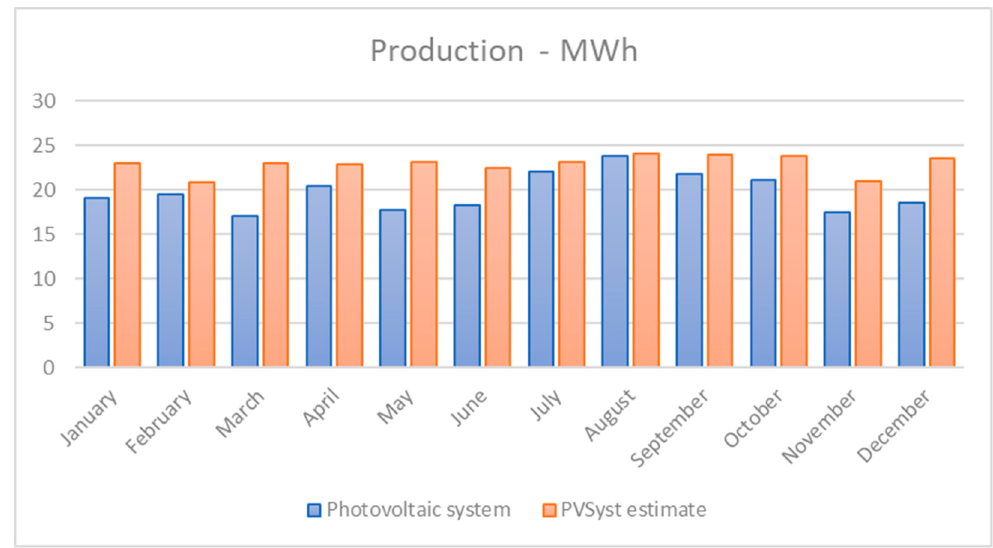
Figure 14. Electricity production by photovoltaic system case study in 2019 and PVSyst estimate.